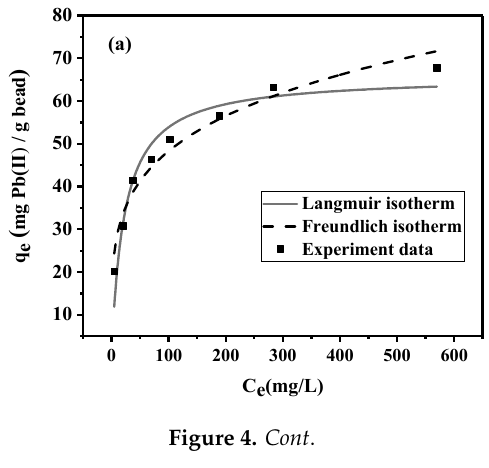
Figure 4. Adsorption isotherms of lead onto peptide bead: ( a ) nonlinear fitting by Langmuir and Freundlich isotherms; ( b ) linear Langmuir isotherm; and ( c ) linear Freundlich isotherm. 3.3. Reusability of Peptide-Linked Bead To evaluate whether the peptide-linked bead is reusable, the amounts of adsorbed/desorbed lead were quantified during six adsorption–desorption cycles. Although the exact mass balance between the adsorbed/desorbed amounts of lead was not observed in Figure 5, small differences in mass balance may be attributed to the incomplete desorbing operation by EDTA. The adsorbed amount of lead, and eventually the desorbed amount, gradually decreased during the successive use of the peptide bead. Compared to the first adsorption capacity (33.4 mg/g bead), the regenerated 2